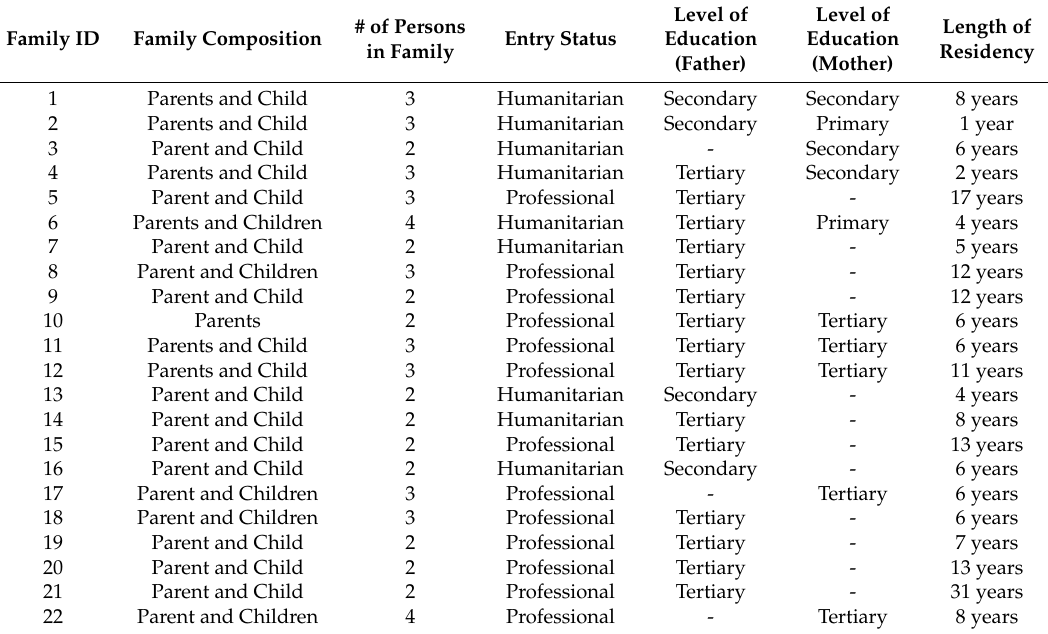
Table 1. Study participants’